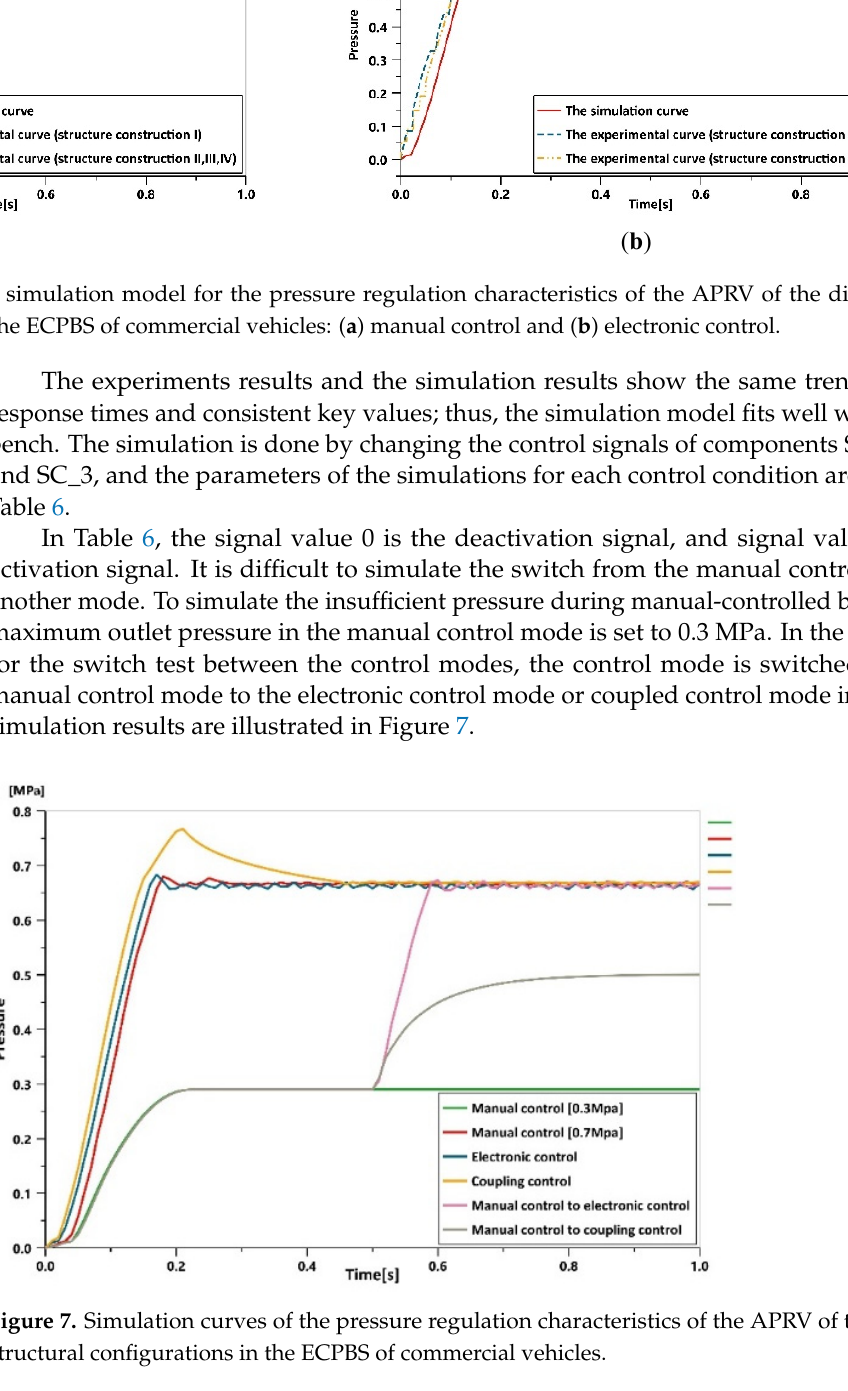
Figure 7. Simulation curves of the pressure regulation characteristics of the APRV of the different structural configurations in the ECPBS of commercial vehicles.